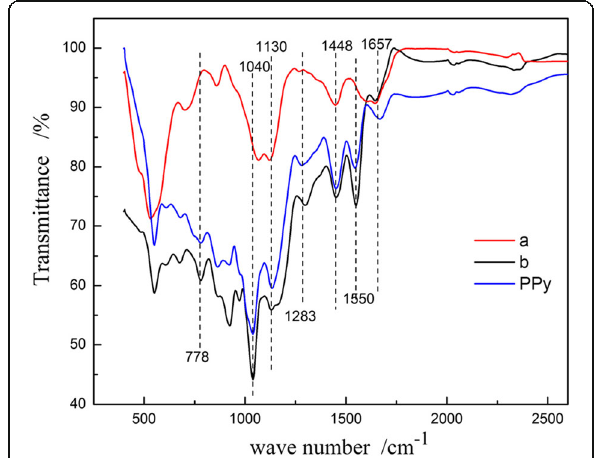
Fig. 2 FT-IR spectra of (a) 30 μ L PPy-coated urchin-like MnO 2 sample and (b) 50 μ L PPy-coated caddice-clew-like MnO 2 sample and pure